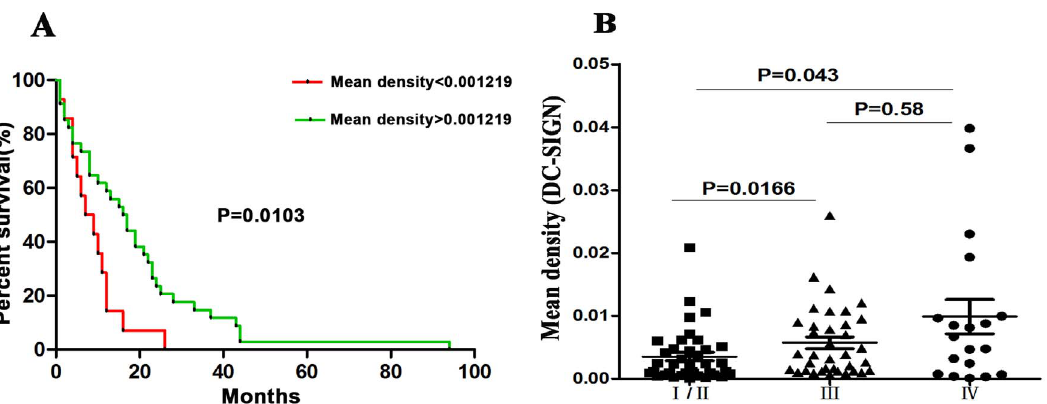
Fig. 6. Aberrant correlation between DC-SIGN expression in colon cancer tissues and patient survival. A : Survival curves by DC-SIGN expression in colon cancer patients. The percent survival of patients with a mean density . 0.001219 was higher than for those with mean density , 0.001219 (Mantel-Cox, P 5 0.009). B : The mean density of DC-SIGN in stage I/II colon cancer patients were notably lower than that in III or IV colon cancer patients according to TNM staging system, P ,